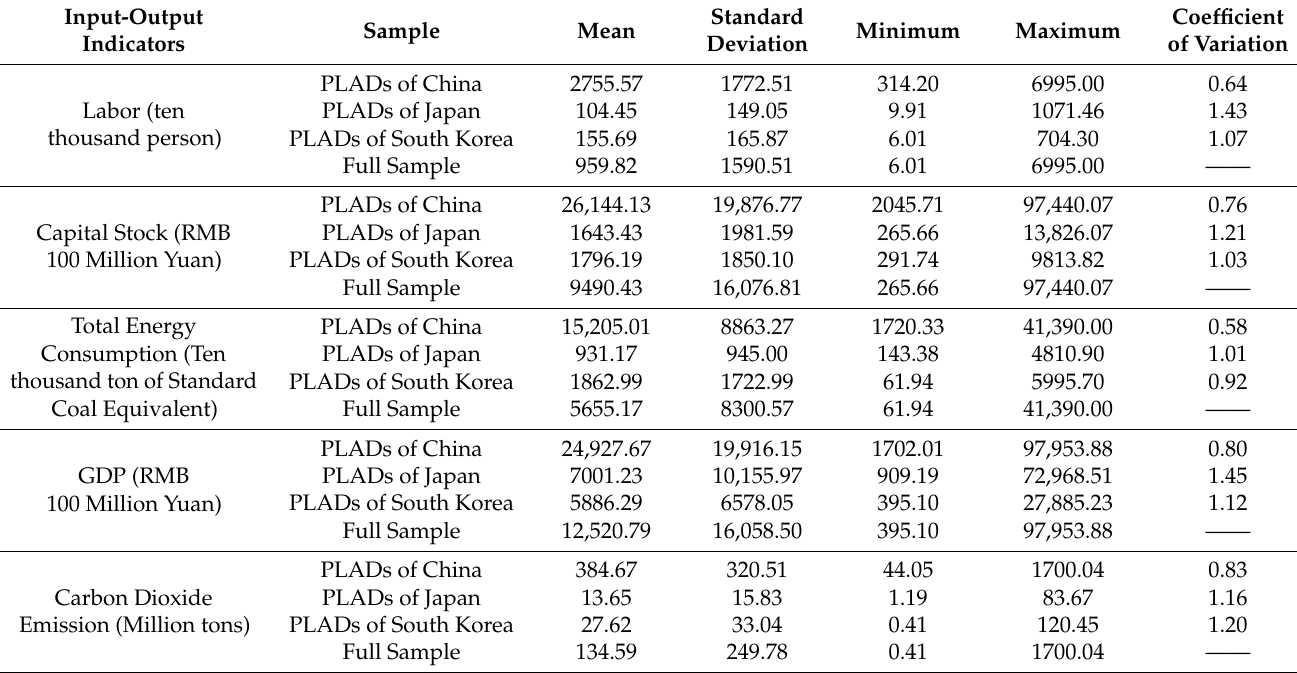
Table 4. Descriptive statistics of input-output